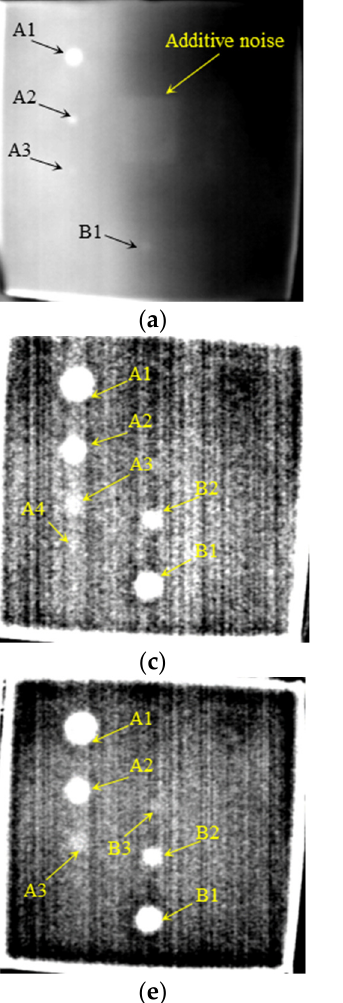
Figure 6. Detection results of voids in silicone rubber. ( a ) The 100th frame RTI. ( b ) The 300th frame RTI. ( c ) The 10th frame 1st DTI. ( d ) The 275th frame 1st DTI. ( e ) The 175th frame 2nd DTI. ( f ) The 450th frame 2nd DTI.